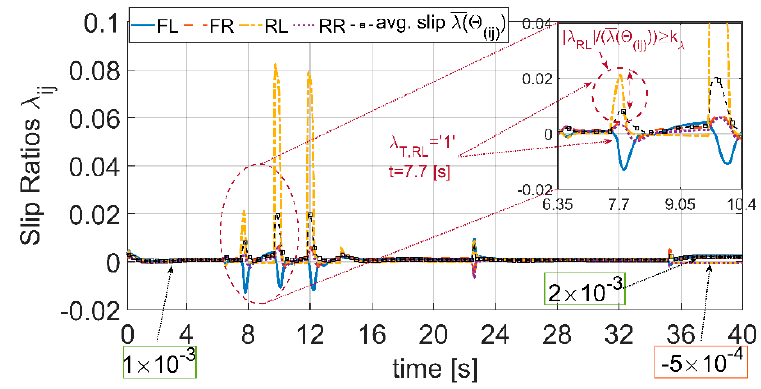
Figure 24. Bending on Low-Friction Patch: four Slip Vectoring coordination.